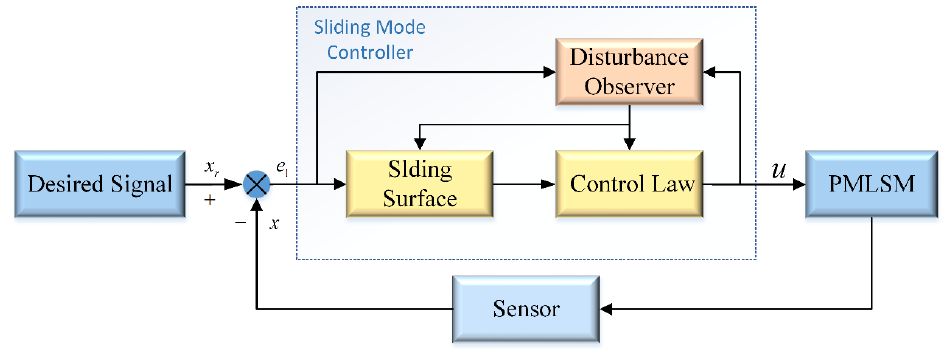
Figure 6. The block diagram of the disturbance observer-based SMC for PMLSM position control.